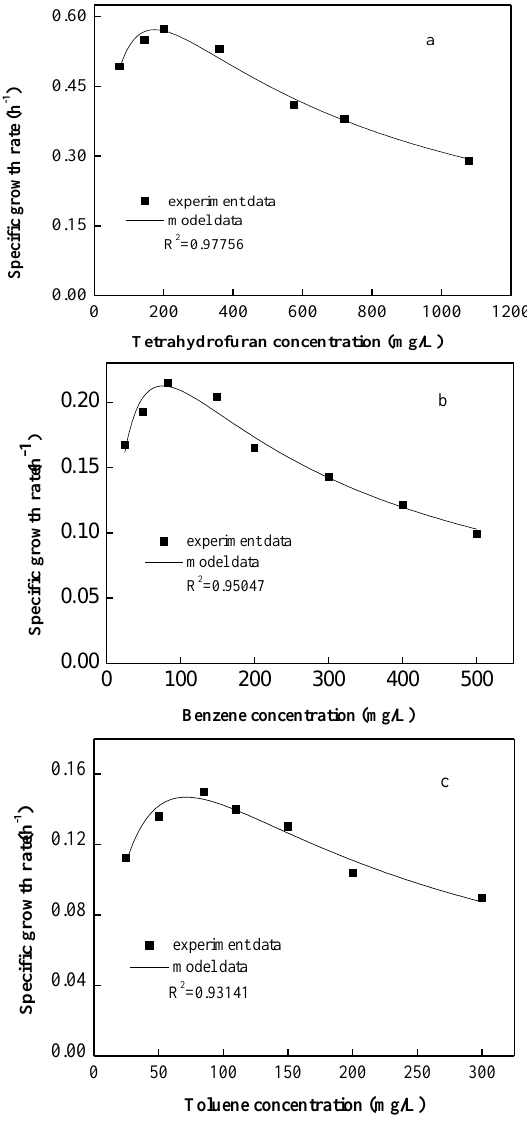
Figure 1. Specific degradation rate of strain DT4 at various concentrations of ( a ) tetrahydrofuran, ( b ) B, and ( c ) T. The initial culture density in each bottle was 20